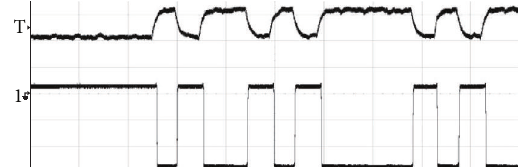
Figure 7: Oscilloscope capture at the outputs of the third stage (demodulation Low Pass Filter) as in lower trace of Figure 6 and Pulse Shaping Stage (data output) of the receiver. The signal is finally restored to the voltage levels of the demodulated data waveform.